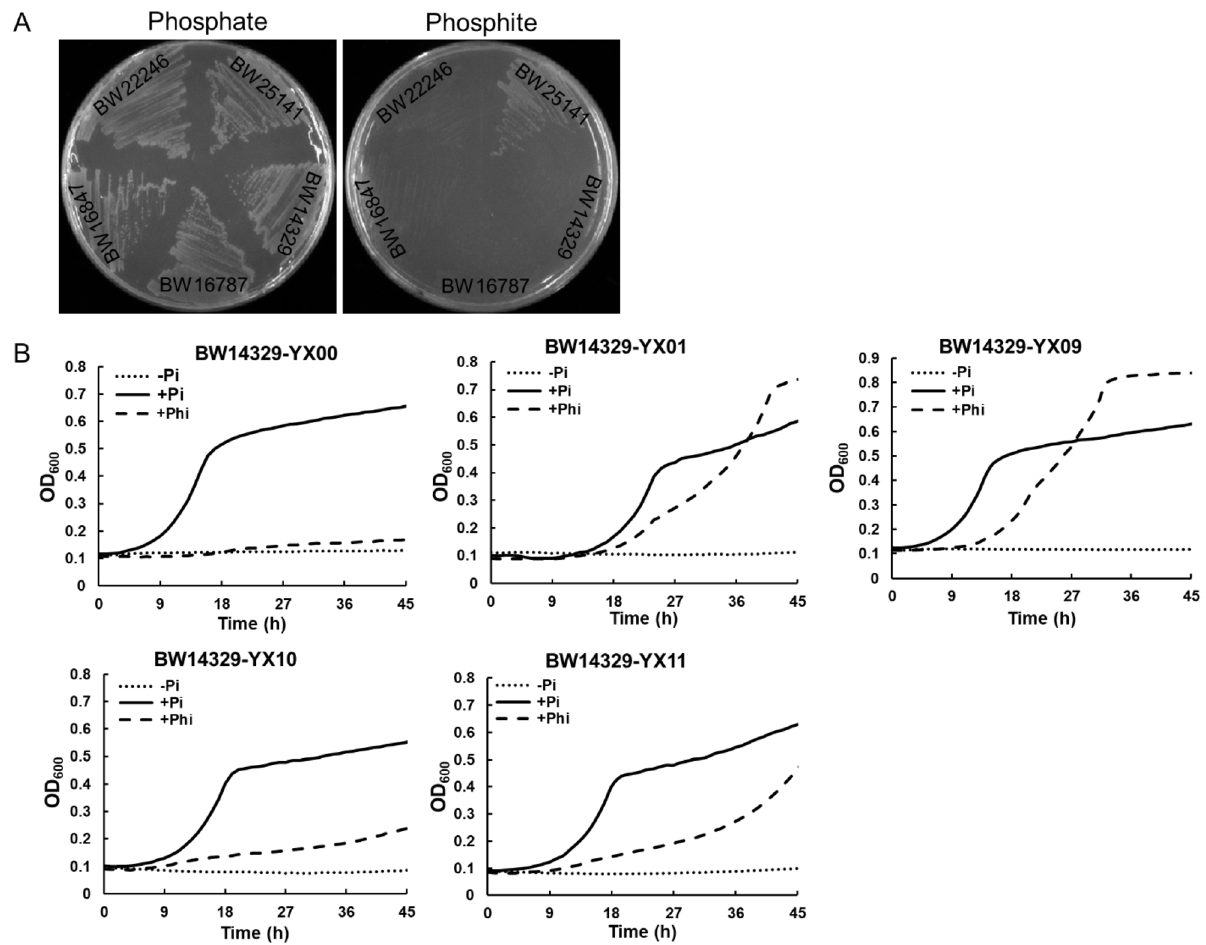
Figure 3. Growth of E. coli strains in MOPS minimal media supplemented with different phosphorous sources. ( A ) Growth behavior of strains cultured on solid medium. The concentration of phosphate or phosphite is 1 mM. ( B ) Growth behavior of engineered strains cultured in liquid medium supplemented with phosphate (solid line) or phosphite (dashed line) as phosphorous sources and without phosphorus sources (dotted line). Phi, phosphite. Pi, phosphate. BW14329-YX00, BW14329-YX01, BW14329-YX09, BW14329-YX10 and BW14329-YX11 were with no Pdh, wild type NAD-dependent Pdh, Pdh_I151R, Pdh_I151R/P176R/M207A and Pdh_I151R/P176E expression, respectively. All values reflect the average of three independent cultures.